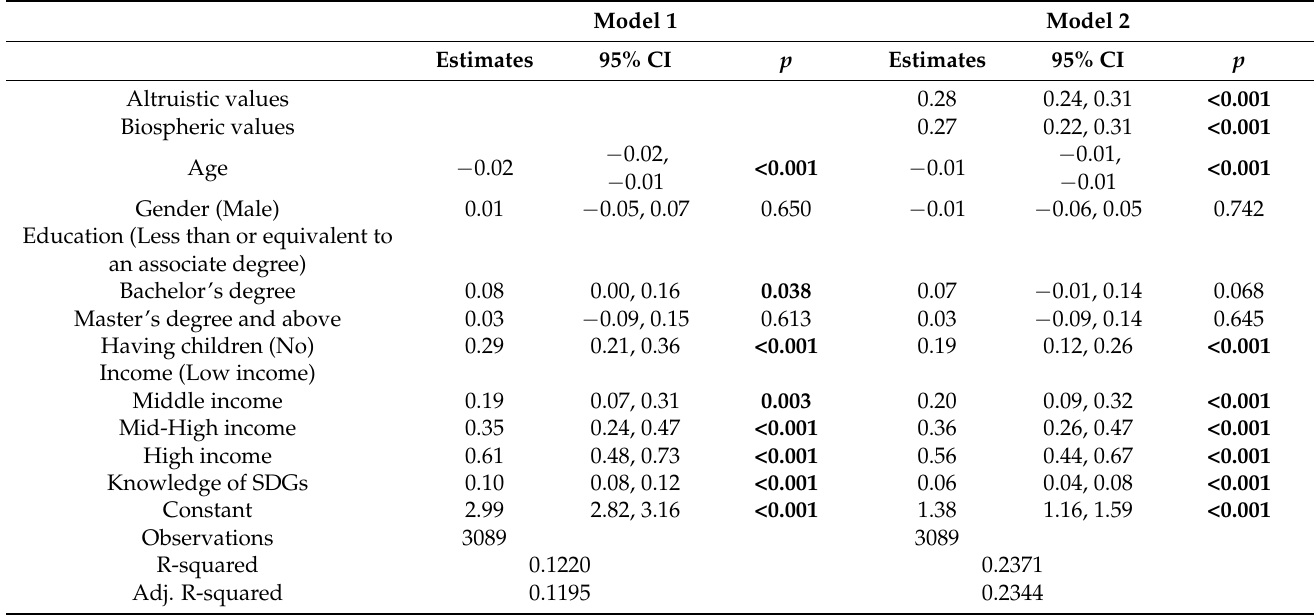
Table 4. Determinants of behavioral intention.